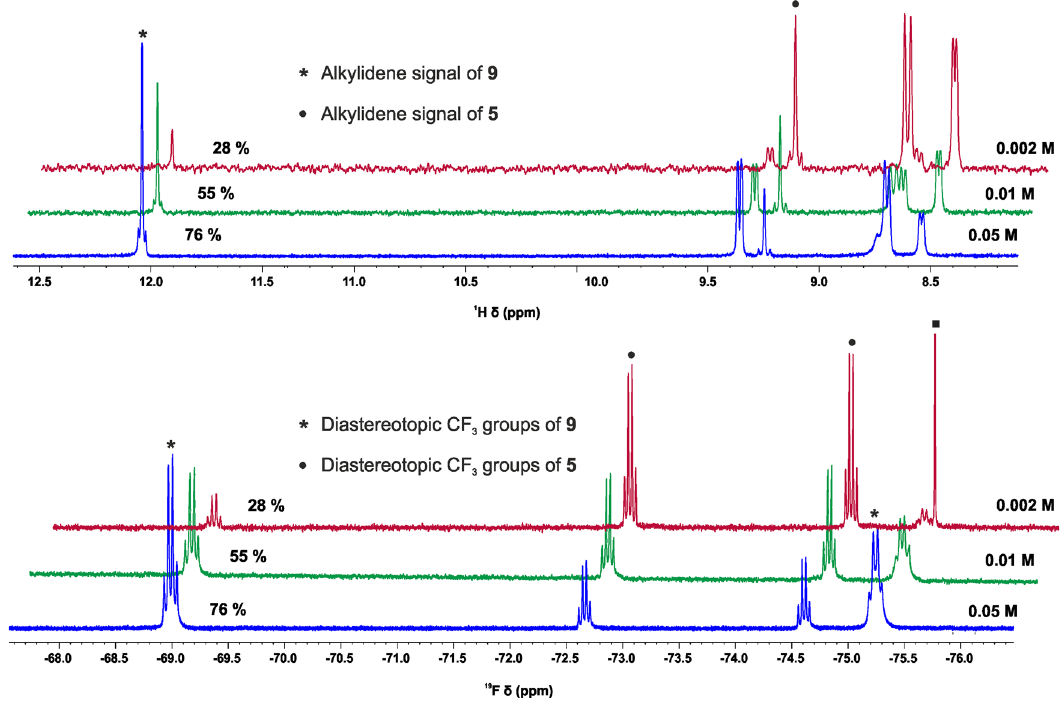
Fig. 5 1 H NMR spectra (alkylidene range) and 19 F NMR spectra of 9 recorded at 25 °C, in C 6 D 6 , at varying concentrations. Concentrations: 0.05 M (blue), 0.01 M (green) and 0.002 M (red). The black square depicts Ph(CF 3 ) 2 COH derived from slight Theoretical calculations of the Gibbs free energies of the results are in line with our experimental observations (Fig. 7; complexation of 5 with 1,10-phenanthroline and 2,2 ′ -bipyridine Supplementary Fig. 17; Supplementary Tables 8 and 9). The provided additional insights into the thermodynamic differences formation of 7 has proved unambiguously exergonic. The Gibbs between the formation of the Fürstner-type adduct 7 and its labile free energy change of complexation with 1,10-phenanthroline is analog 9 . The solution-phase Gibbs free energies were calculated predicted to be − 8.5 kcal·mol − 1 , indicating that the adduct using the density functional theory at the ω B97XD/Def2TZVPP// formation is clearly favored thermodynamically. With bipyridine ω B97XD/Def2SVP level, in benzene as the solvent. The obtained as the Lewis base, the Δ G of the adduct formation is considerably